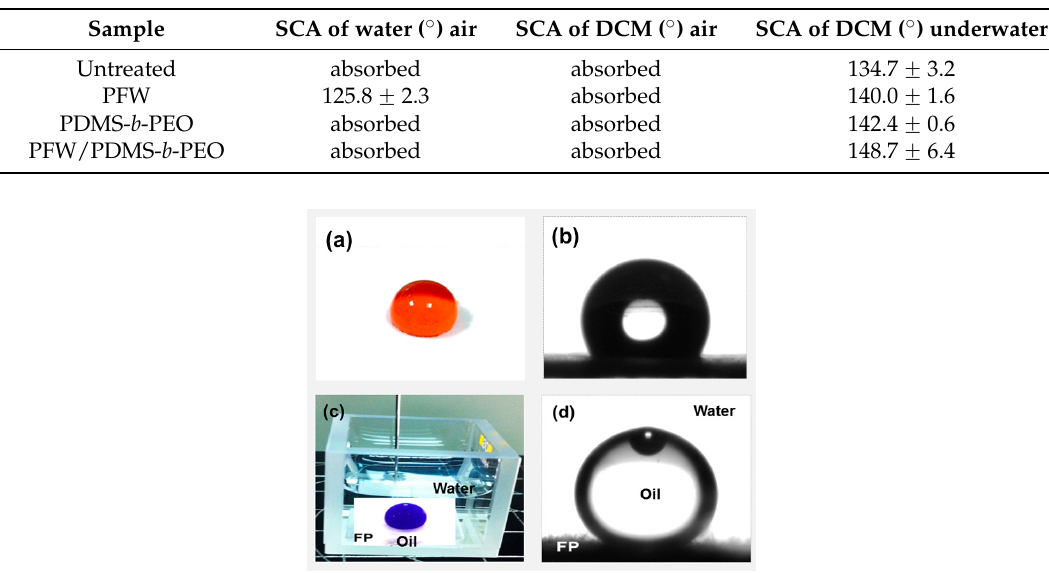
Table 1. Water and oil (DCM) static contact angle (SCA) measurement of untreated, PFW, PDMS- b -PEO and PFW/PDMS- b -PEO treated FP in air and underwater.